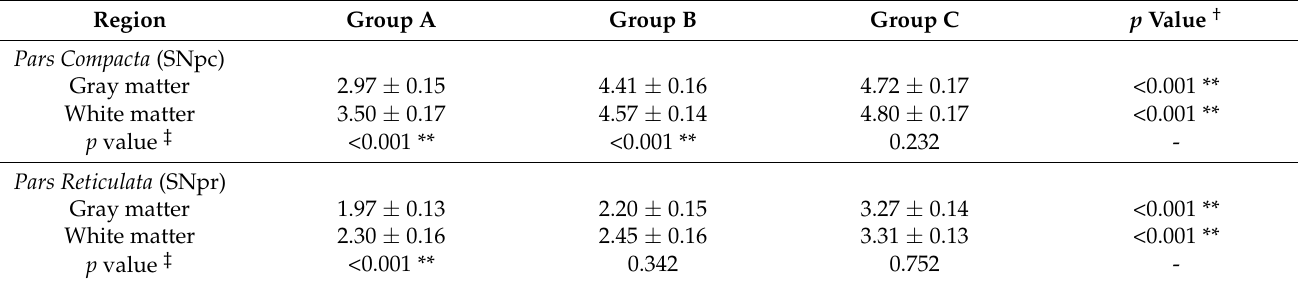
Figure 2. Intergroup analysis of CD68+ cells per visual field in Pars Reticulata (SNpr) for the three studied groups in both ( a ) gray and ( b ) white matter. The analysis was done for both perivascular and diffuse locations. The bar plots indicate the average number of CD68+ cells ± S.E. (Standard Error) seen per visual field. ** indicates a significant difference between the groups ( p < 0.05 with Bonferroni correction is considered significant). Distribution of CD68+ cells per visual field in ( c , f ) Group A (controls); ( d , g ) Group B (age-matched alcoholics) and ( e , h ) Group C (non-age-matched alcoholics). Pink arrows indicate perivascular CD68+ cells; red arrows indicate diffuse CD68+ cells while orange arrows indicate monocytes (seen in the lumen of micro-vessel). Original magnification, 400 × . Scale bars, 50 µ m. Table 5. Distribution of Iba1+ cells per visual field in different regions of Substantia Nigra (SN).